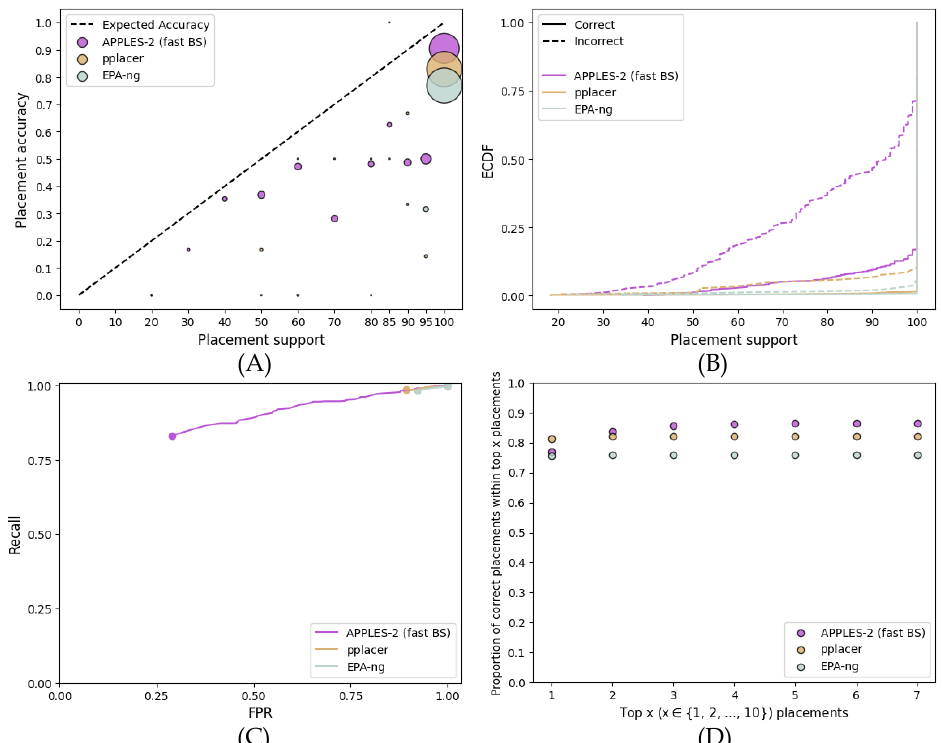
Figure 8. Results for the placement on the species tree using the concatenation of the 50 best genes of the WOL multi-gene dataset. We compared the support values obtained by pplacer and EPA-ng with those obtained by APPLES-2 using fast bootstrapping. ( A ) Support vs. Accuracy, ( B ) ECDF, ( C ) ROC curves, ( D ) Frequency of correct placements within the top 1 ≤ x ≤ 10 highest support placements.